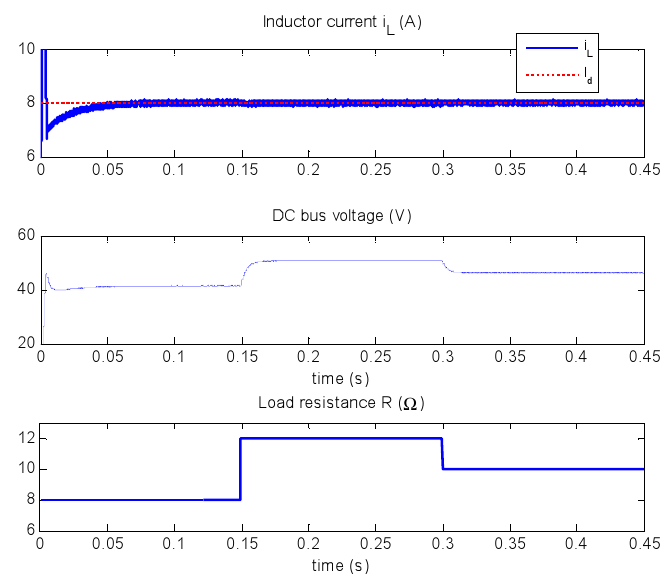
Figure 16. Robustness of the saturated controller in the presence of load resistance uncertainties.